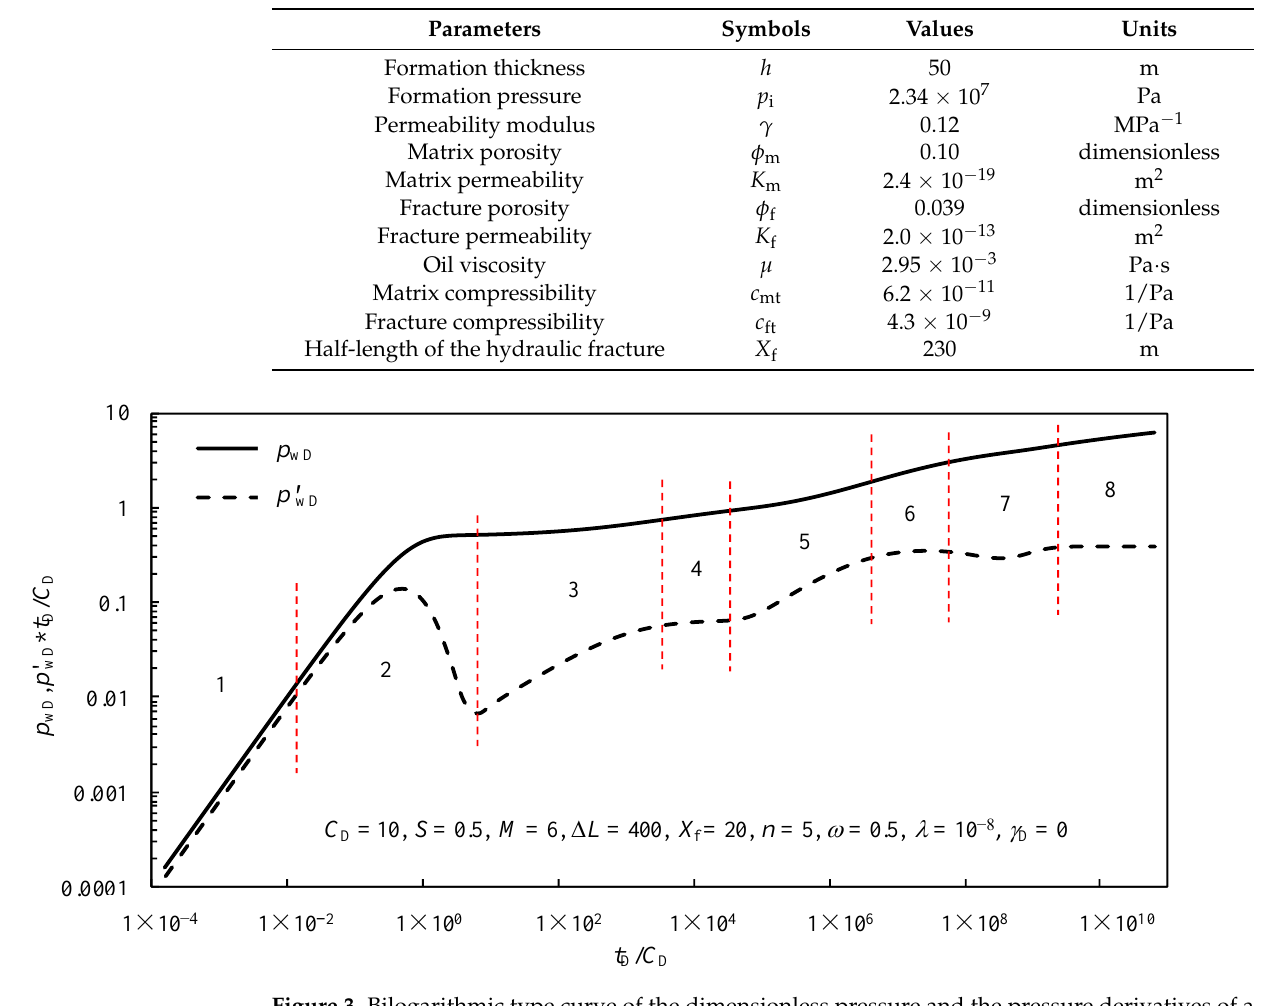
Figure 3. Bilogarithmic type curve of the dimensionless pressure and the pressure derivatives of a MFHW in an inter-salt shale oil reservoir.